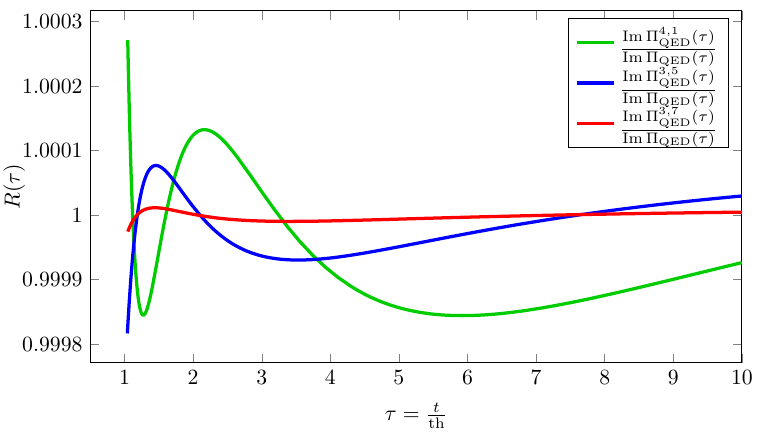
Figure 9 . Plot of the ratios of spectral functions in eq. (A.20). The vertical scale in the figure is very close to the